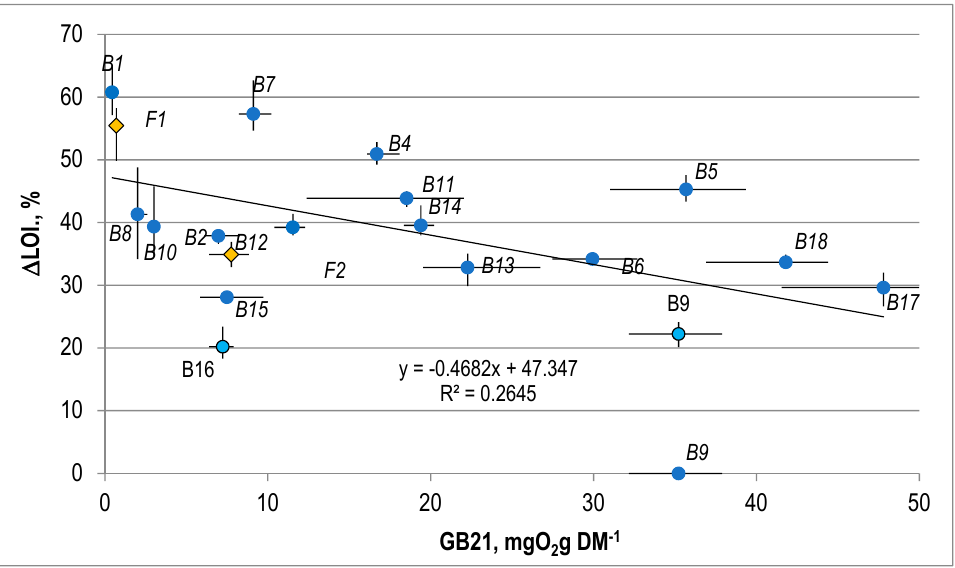
Figure 6. The correlation between the LOI and the GB21 for the stabilized waste.